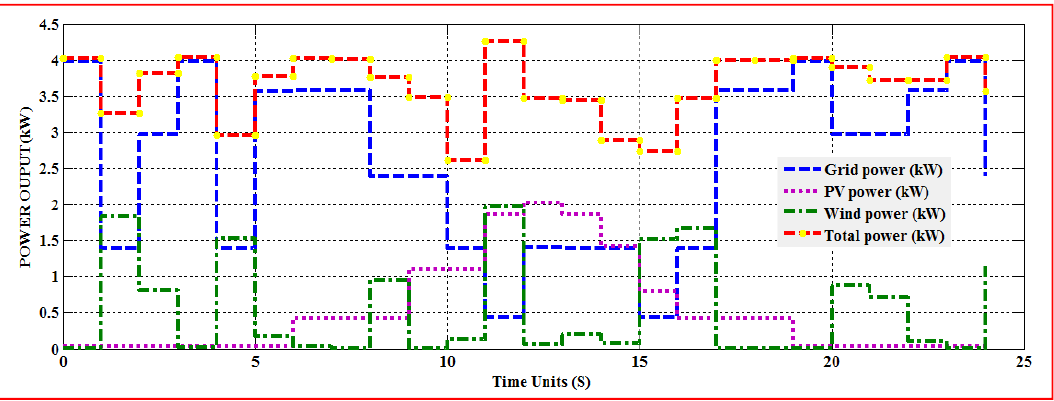
Figure 15. Simulation output for renewables with grid combination.